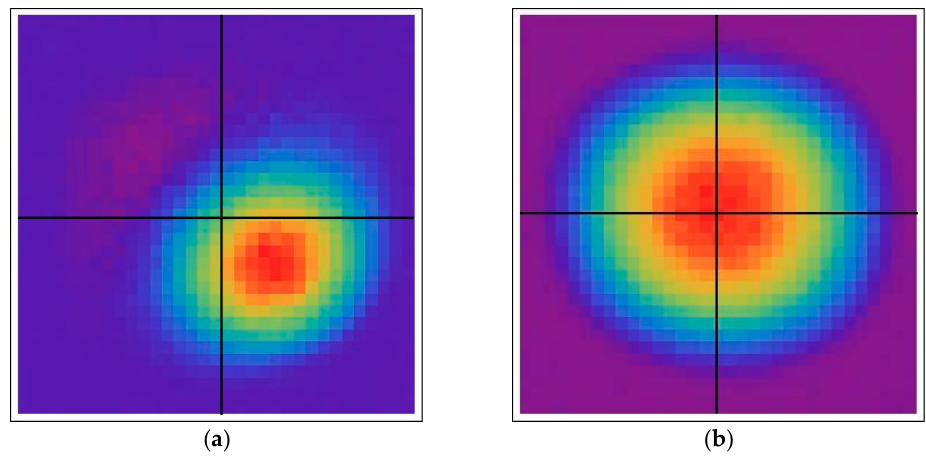
Figure 13. ( a ) Color contour plot of the count rate from the lower right detector as a function of the position of a small light spot raster scanned over the area of the quad cell; ( b ) Contour plot of the sum of the count rates from all four pixels as a function of light spot position.